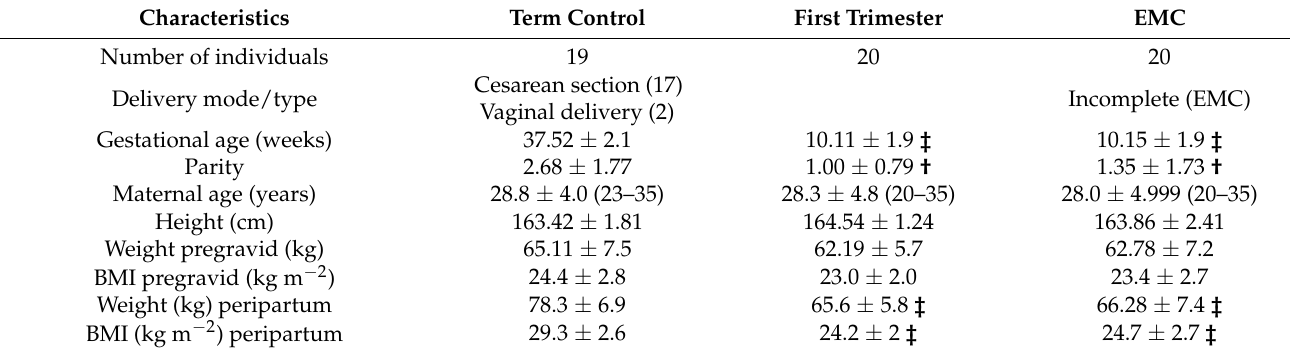
Table 1. Anthropometric and clinical data of early miscarriage (EMC) patients, 1st trimester, and term controls. Characteristics